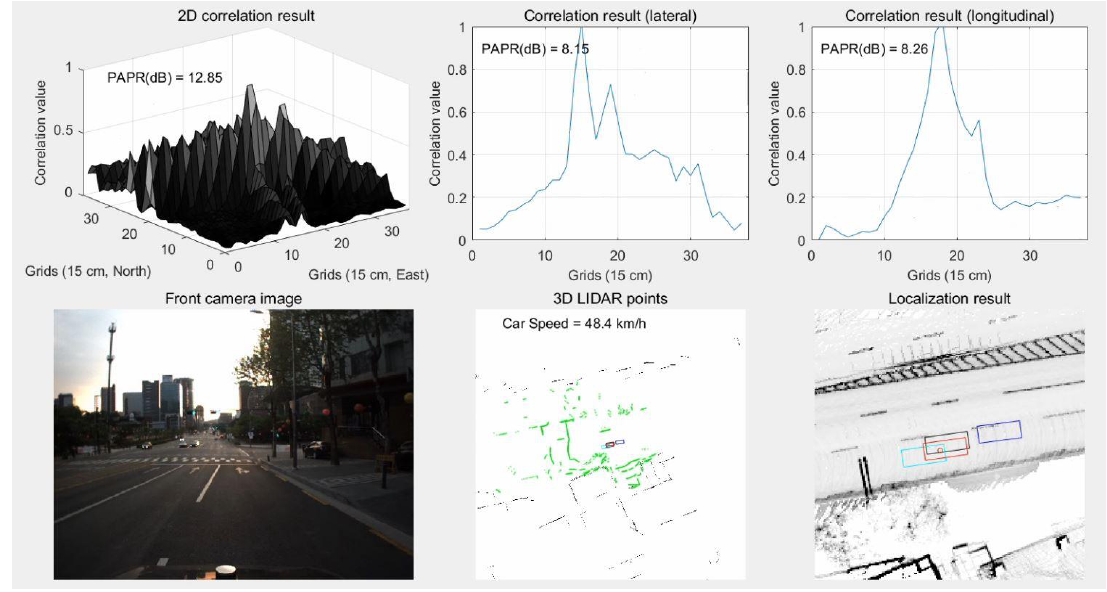
Figure 31. Results of localization using vertical structures in area with a small number of nearby buildings.